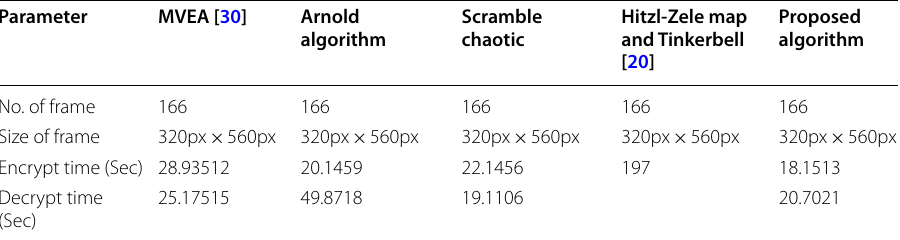
Table 9 Features of encryption and decryption frames and elapsed time for traditional techniques and proposed